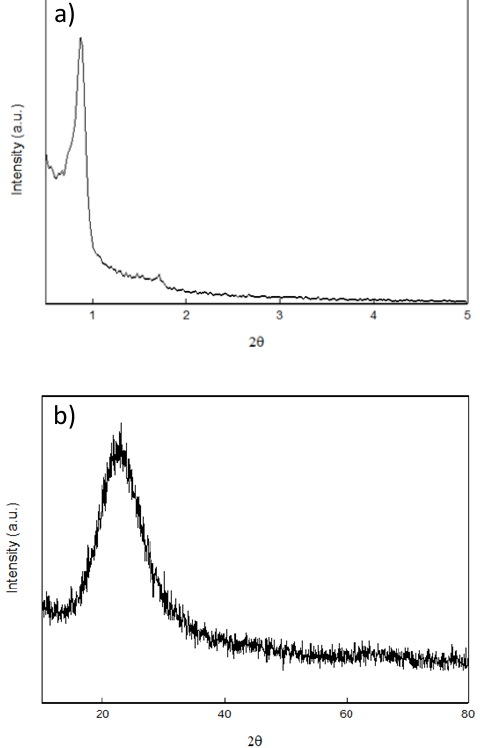
ff ractograms corresponding to the PMO-Py material: ( a ) low-angle, ( b ) Figure 6. X-ray diffractograms corresponding to the PMO-Py material: a ) low-angle, b ) wide-angle. Figure 6. X-ray di